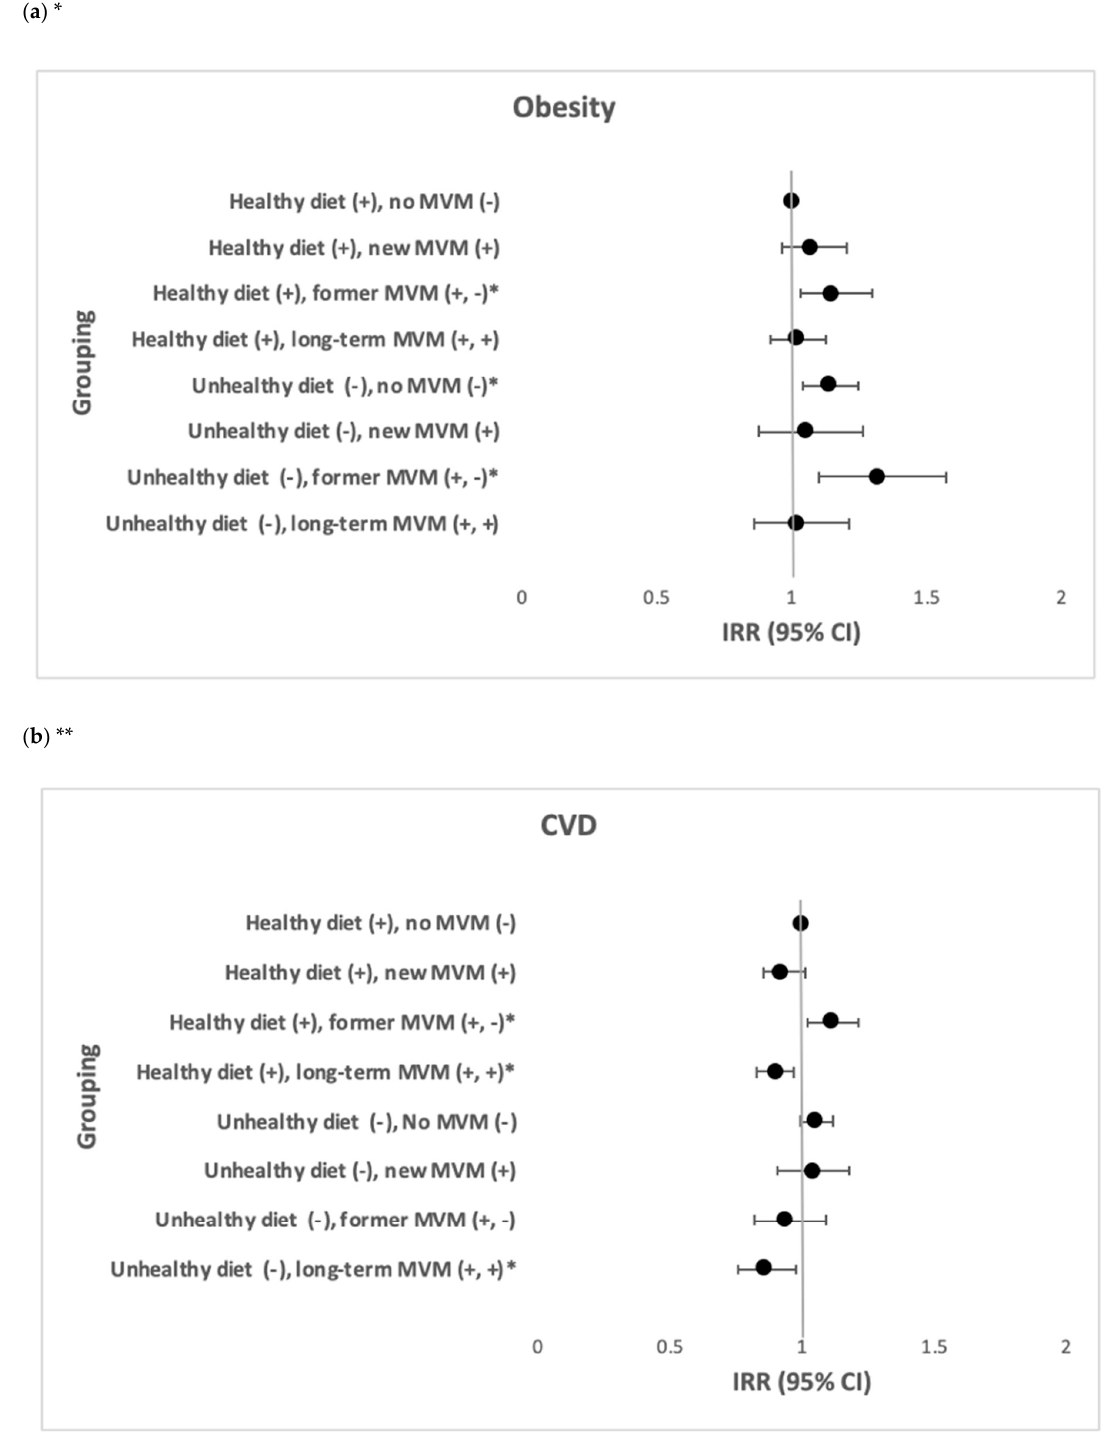
Figure 3. The joint effects of healthy vs. unhealthy diet and minerals and multivitamins. consumption in relation to the incidence of obesity and CVD (N = 69,990) ( a ) The joint effects of healthy vs. unhealthy diet and minerals and multivitamins. consumption and in relation to the incidence of obesity. ( b ) The joint effects of healthy vs. unhealthy diet and minerals and multivitamins. consumption and in relation to the incidence of CVD. * IRR after adjustment of age, gender, country of birth, marital status, education, SEIFA, smoking, physical activity, CVD, diabetes, blood cholesterol and blood pressure. ** IRR after adjustment of age, gender, country of birth, marital status, education, SEIFA, smoking, physical activity, obesity, diabetes, blood cholesterol and blood pressure.